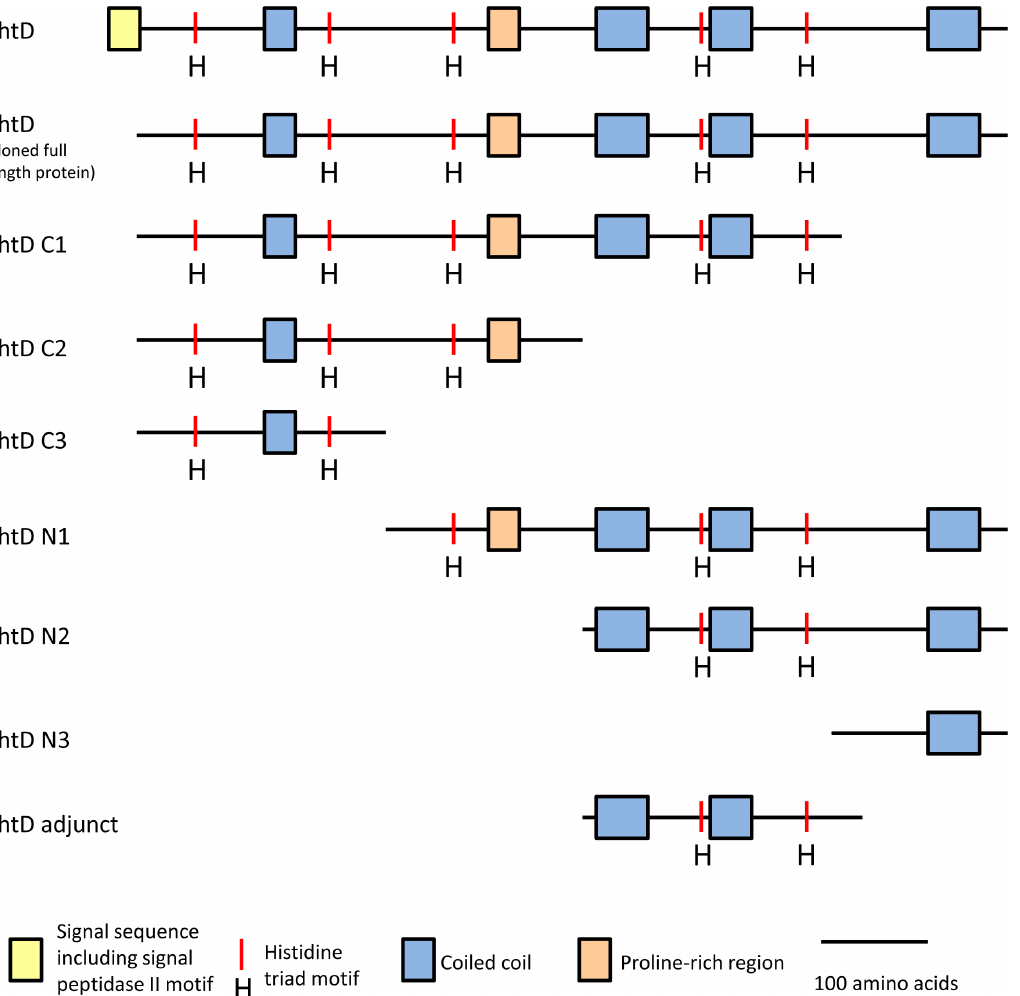
Figure 2. Truncated forms of PhtD used in this study. Proteins are shown with known or predicted domains annotated. The N termini are to the left.